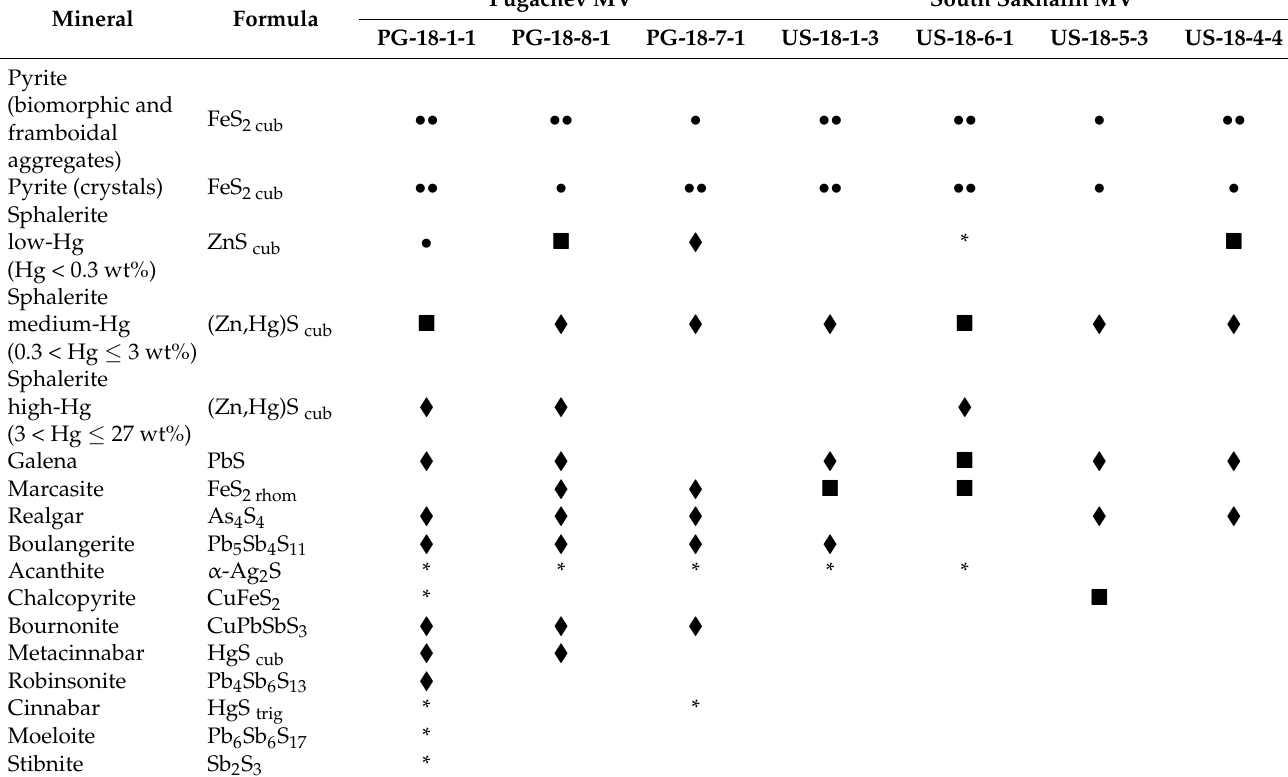
semblages of ultrastable minerals, with predominant double-headed zircon crystals and colorless F-Cl-bearing apatite, and with few grains of rutile, ilmenite, garnet, clinopyrox- ene and amphibole. The South Sakhalin MV mud masses and pulp enclose numerous fragments and fine debris of coaliferous rocks (Figure 3c), and often contain spherulitic dawsonite (NaAl(CO 3 )(OH) 2 ) and sporadic bastnäsite (LREE(CO 3 )F) grains. Sulfate as- semblages consisting of baryte, gypsum, and anglesite (PbSO 4 ), as well as rhabdophane (LREE(PO 4 ) · nH 2 O) and florencite (LREEAl 3 (PO 4 ) 2 (OH) 6 ) authigenic phosphates, are iden- tical at both sites. The heavy-fraction mud samples from both Sakhalin MVs bear diverse Fe, Zn, Pb, As, Hg, Sb, Ag, and Cu sulfides (14 mineral species totally) (Table 2) and show similar patterns of chalcophile elements. Table 2. Sulfide assemblages extracted from the heavy fractions and mud masses of Pugachev and South Sakhalin MVs, Sakhalin Island. Pugachev MV South Sakhalin MV Mineral Formula